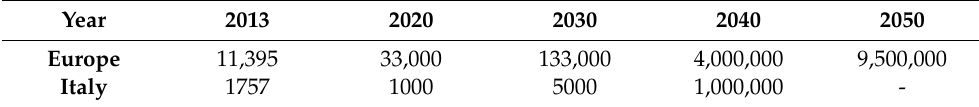
Table 1. Estimate of tons of waste from PV panels in Europe and Italy.